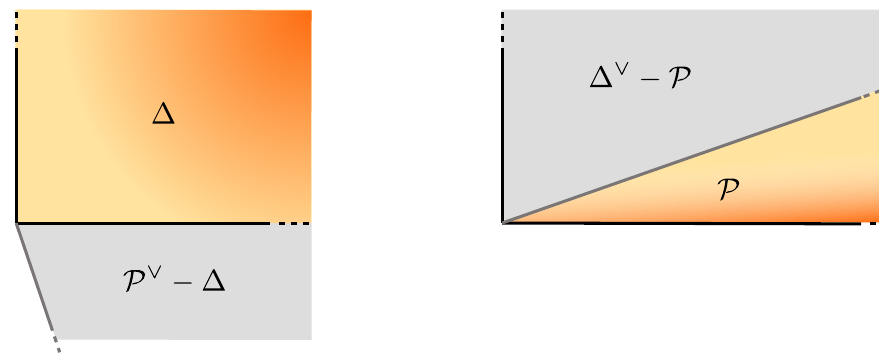
Figure 3 . Saxionic cones and their duals ∆ ⊂ P ∨ and P ⊂ ∆ ∨ of the two-Kähler-moduli heterotic model. Here we are suppressing the R > 0 piece of the moduli space that corresponds to s 0 . The darker shaded regions correspond to the perturbative regime